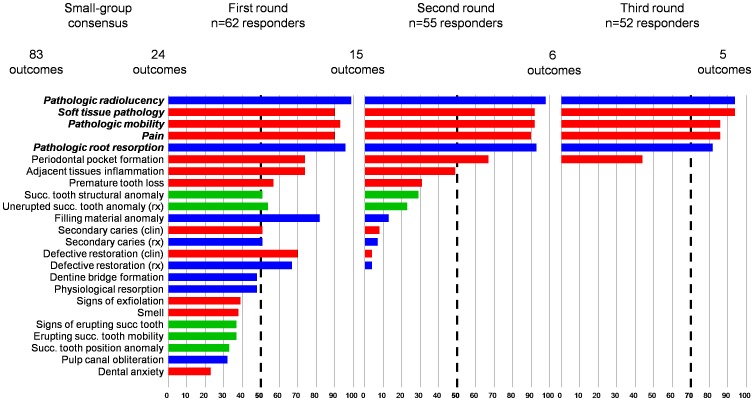
Outcomes flow chart and results of the Delphi process.Succ, succedaneous. Clinical outcomes are in red, radiological outcomes in blue, outcomes pertaining to permanent teeth in green.